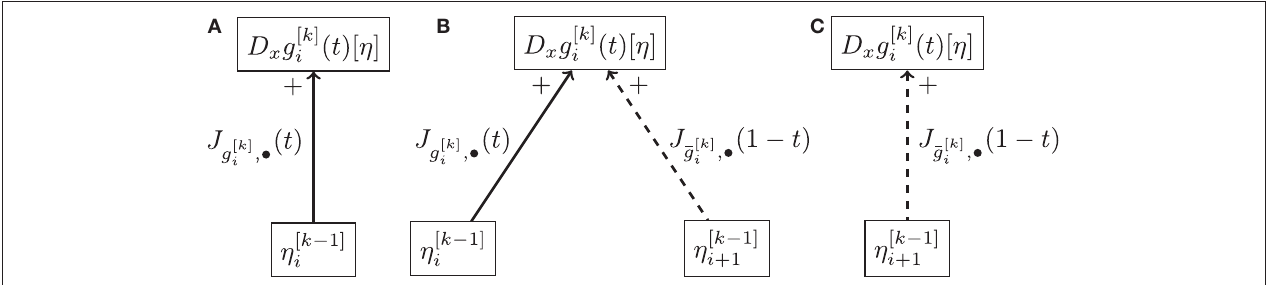
FIGURE 5 | Schematic representation of the cases where elements compose the chained derivative of the i th Bézier curve of order k in the De Casteljau algorithm. The solid line represents a Jacobi field along g [ k ] i , while the dashed one represents a reversed Jacobi field. (A) Represents the case x b i where x k 1 , ... , b i 1 } , and (C) represents the case x = b i ∈ { + + +